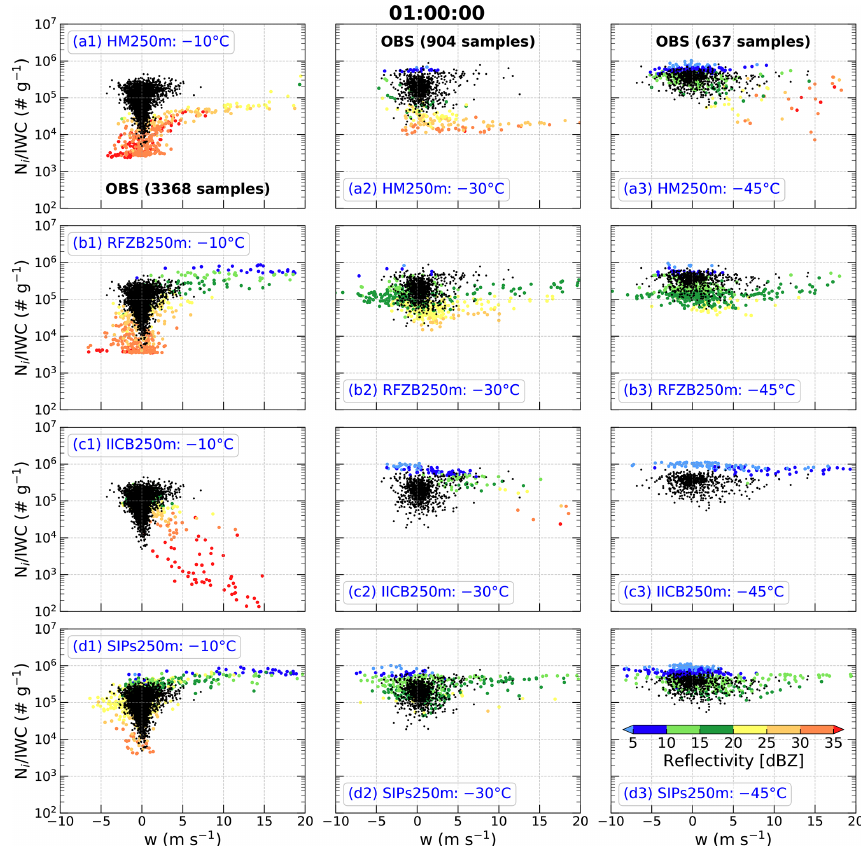
Figure A2. As in Fig. 6 but overlaid with observations in Fig.